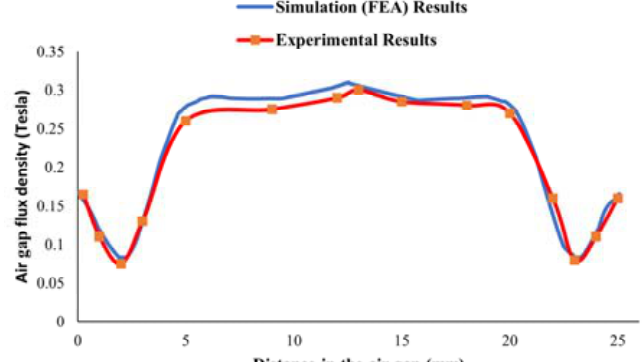
Figure 18. Measured and simulation results of the magnetic flux density in the air gap of the motor at no ‐ load conditions.